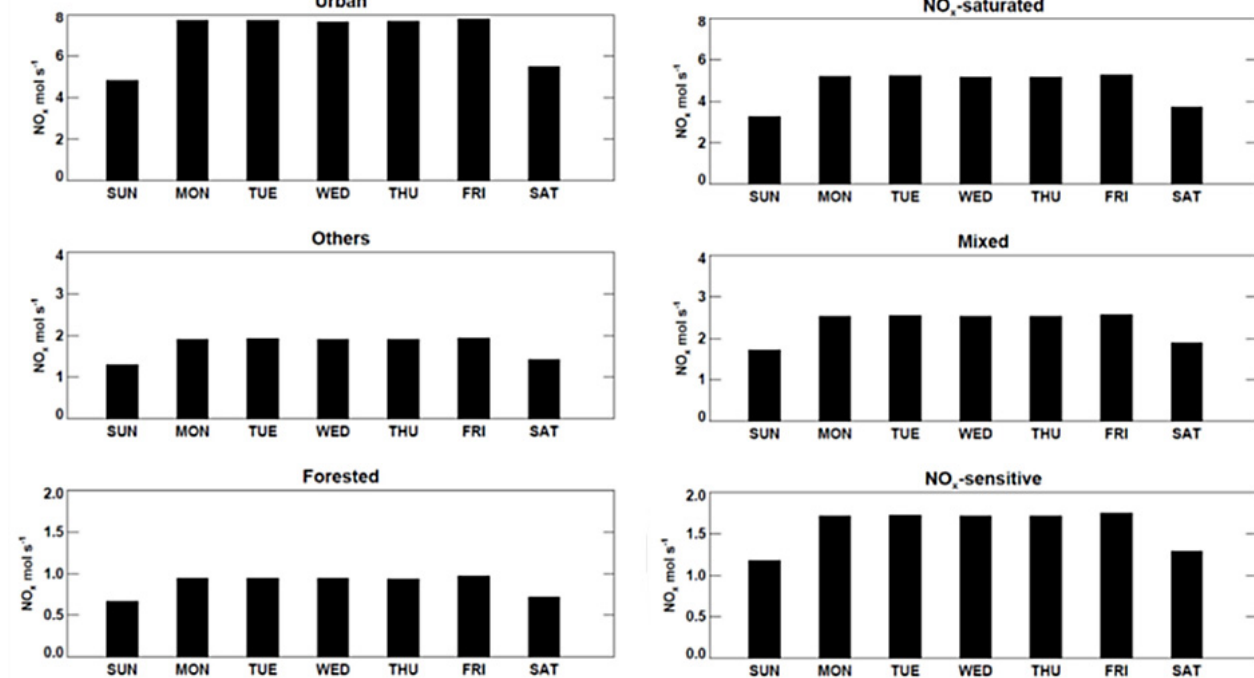
Fig. 5. Weekly variation in NO x emissions at EPA AQS stations over three AVHRR-derived geographical regions (i.e., urban, other, and forest regions, left column) and GOME-2-derived chemical regimes (i.e., NO x -saturated, mixed, and NO x -sensitive regimes, right column) in CMAQ for August 2009. For the sake of consistency with the daytime O 3 comparison in Fig. 7, only daytime (01:00–05:00p.m., local time) NO x emissions are used; some data are filtered out from 17–19 August 2009, when Tropical Storm Ana strongly affected air quality over the eastern